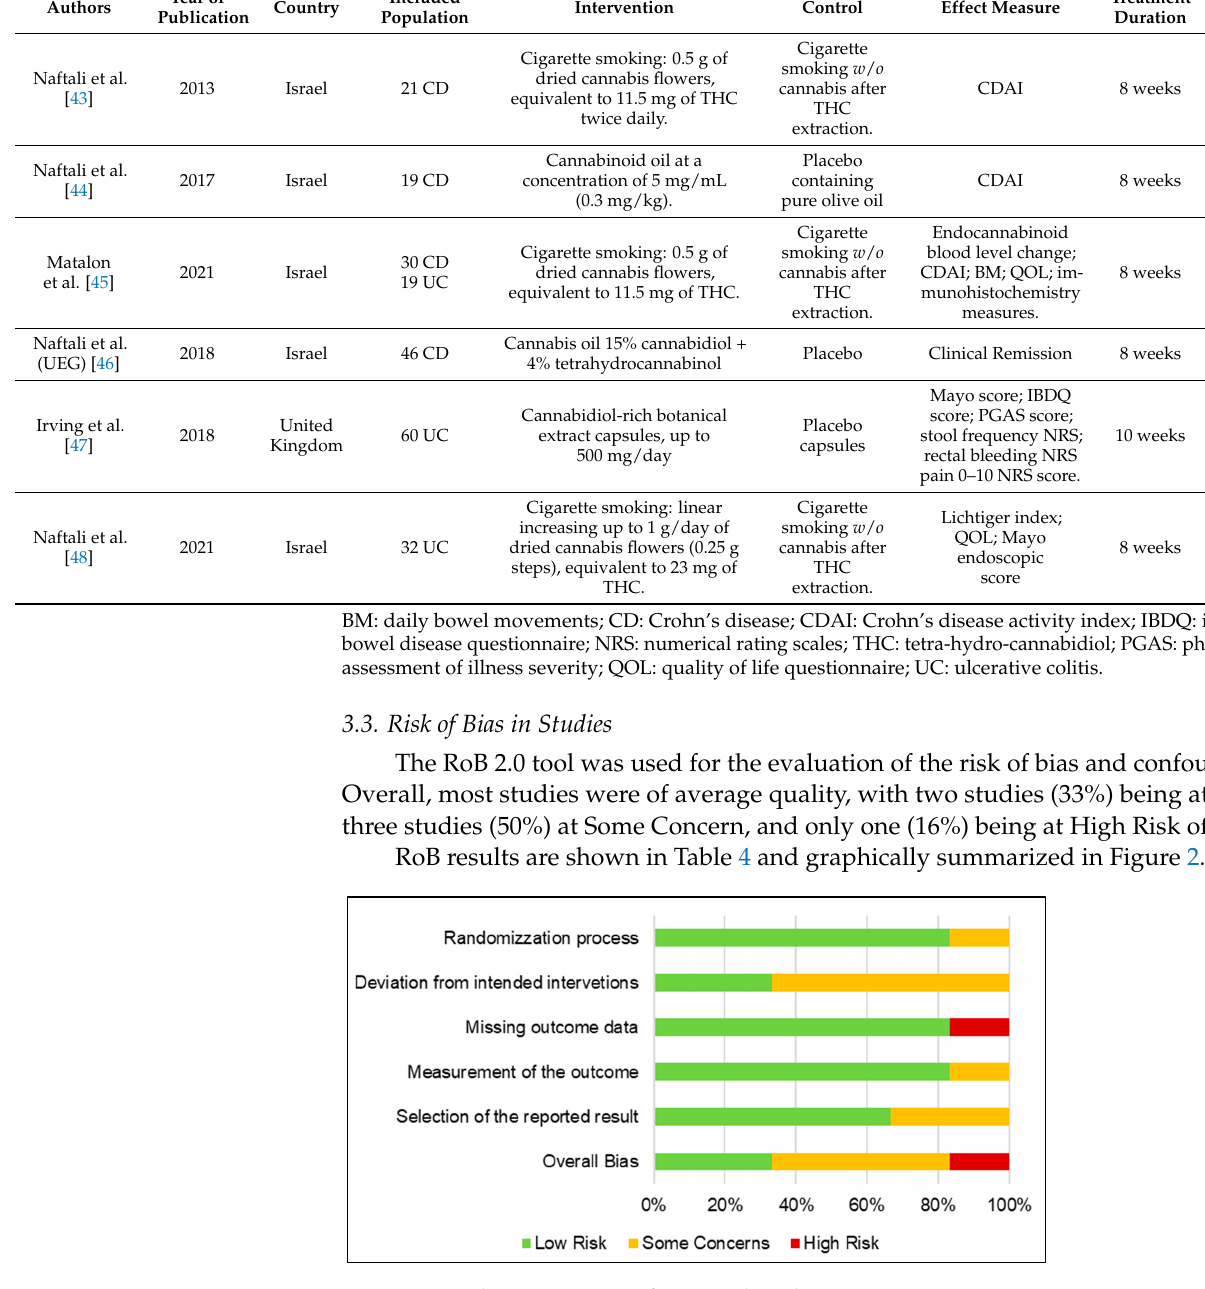
Figure 2. Quality assessment of retrieved studies. Table 4. RoB quality assessment of included studies. Green: low risk of bias; Yellow: some concerns in bias assessment; Red: High risk of bias.